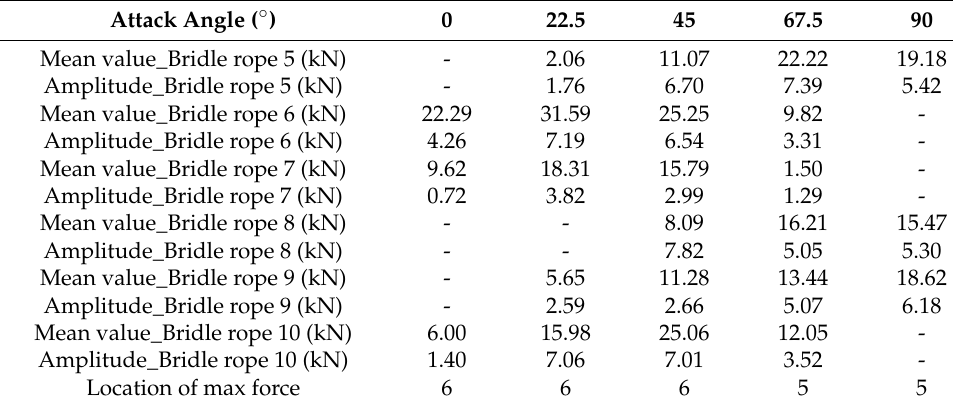
Table 7. Mean values and amplitudes of the mooring forces on bridle ropes under different attack angles.